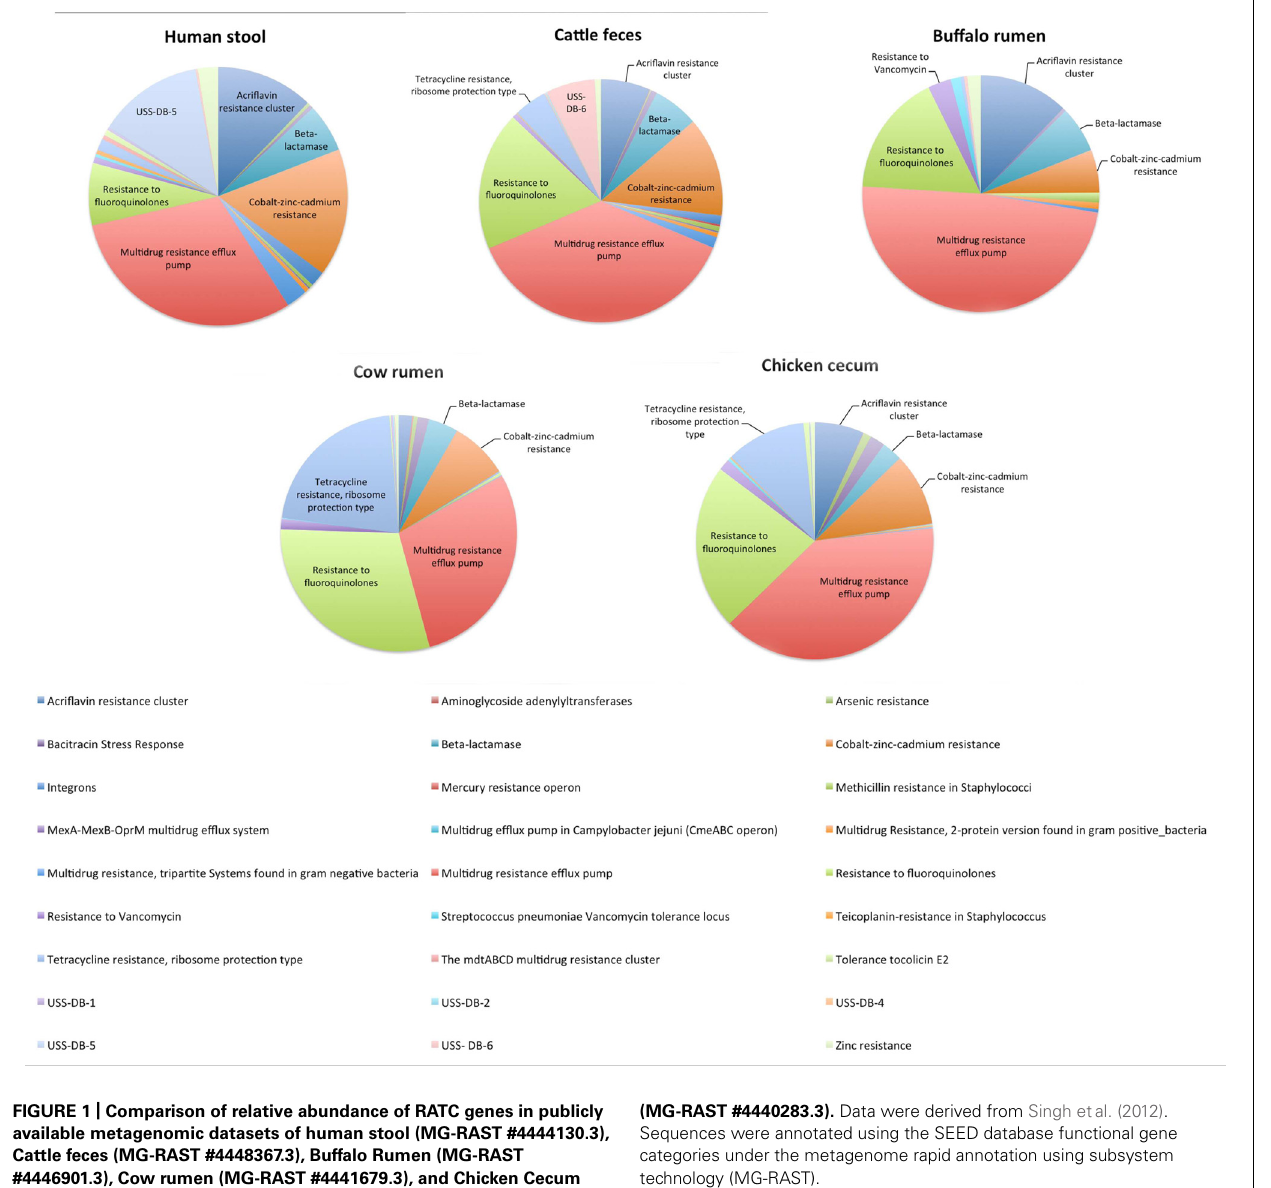
FIGURE 1 | Comparison of relative abundance of RATC genes in publicly available metagenomic datasets of human stool (MG-RAST #4444130.3), Cattle feces (MG-RAST #4448367.3), Buffalo Rumen (MG-RAST #4446901.3), Cow rumen (MG-RAST #4441679.3), and Chicken Cecum